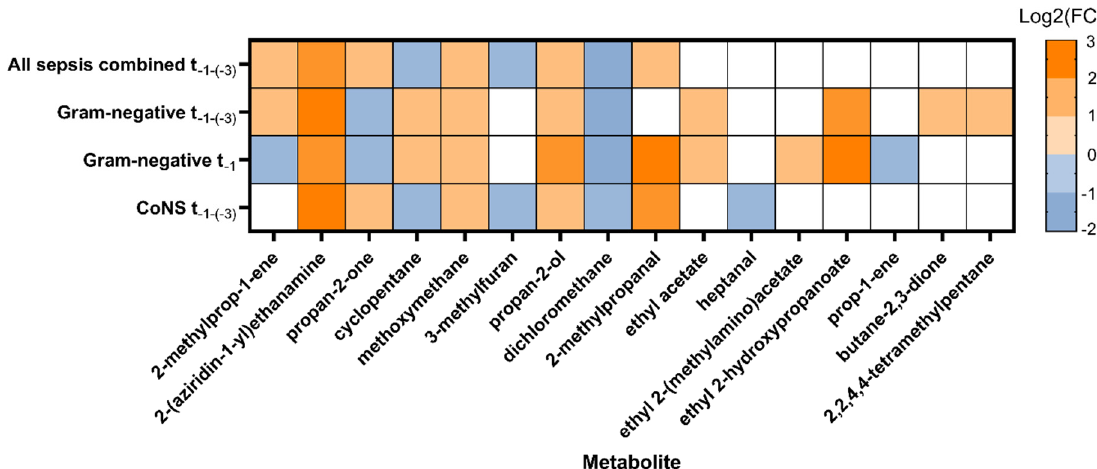
Figure 2. Discriminatory metabolites identified using GC-TOF-MS. The log2(FC) of the median peak height intensities is depicted for every significant comparison, indicating an increase (orange) or decrease (blue) in metabolite abundance in LOS cases. White indicates that the metabolite was not considered discriminatory for that subgroup. Gram-positive LOS is not depicted since there were no significant comparisons. Abbreviations: log2(FC), log2(fold change); LOS, late-onset